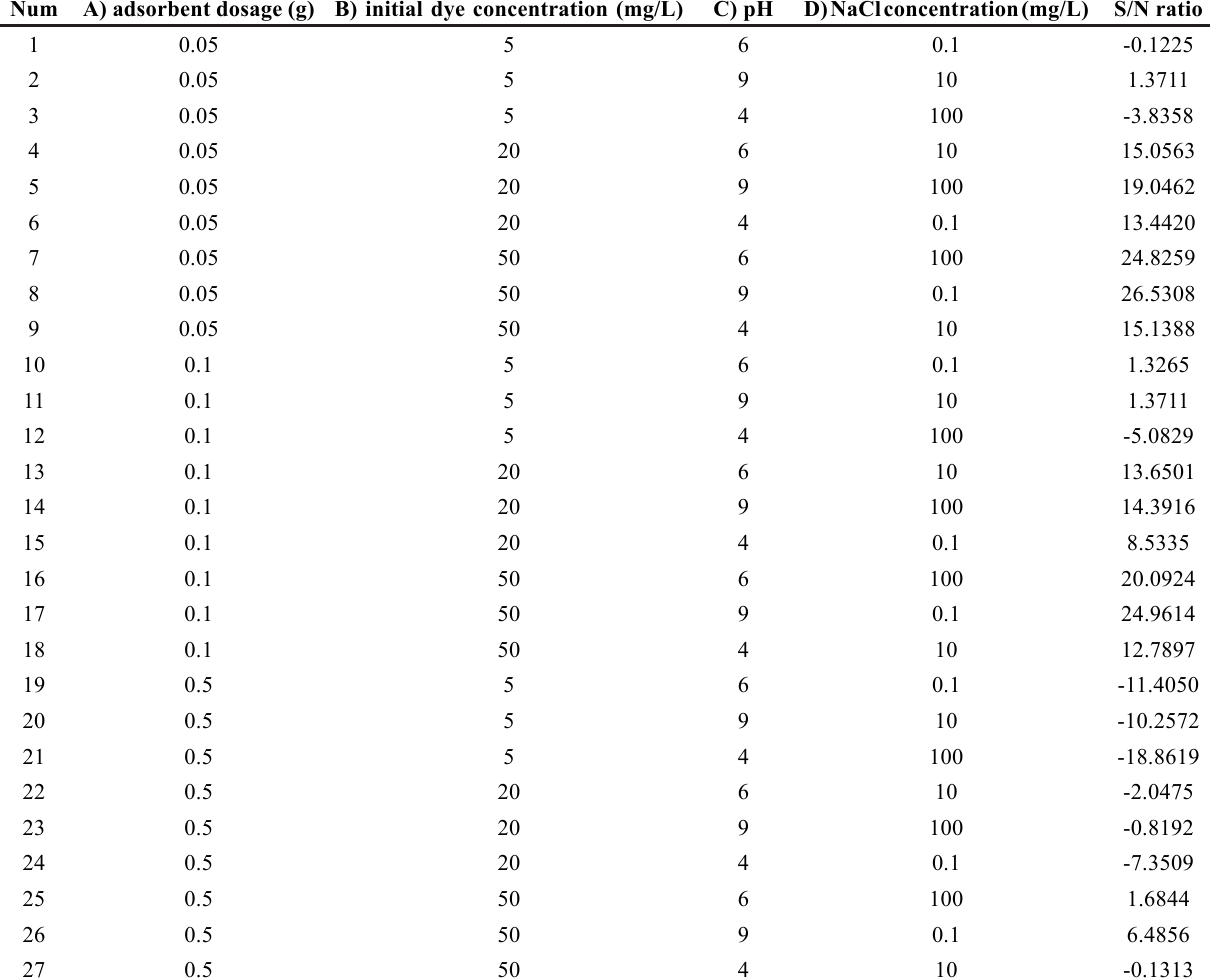
Table 1. Designed experiments by Taguchi